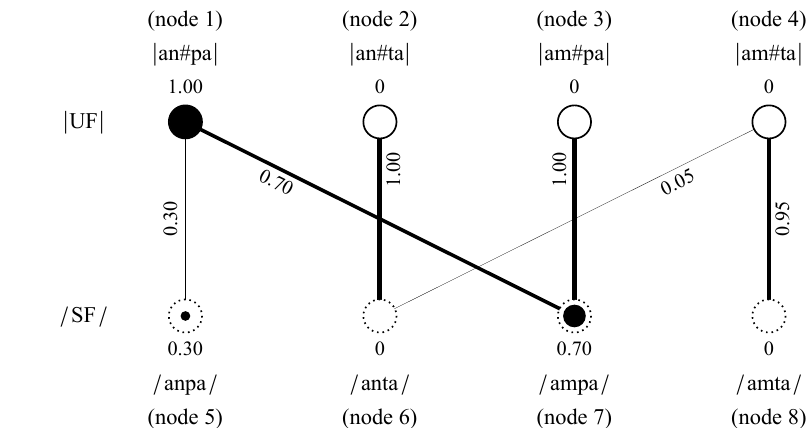
Figure 4: The production of